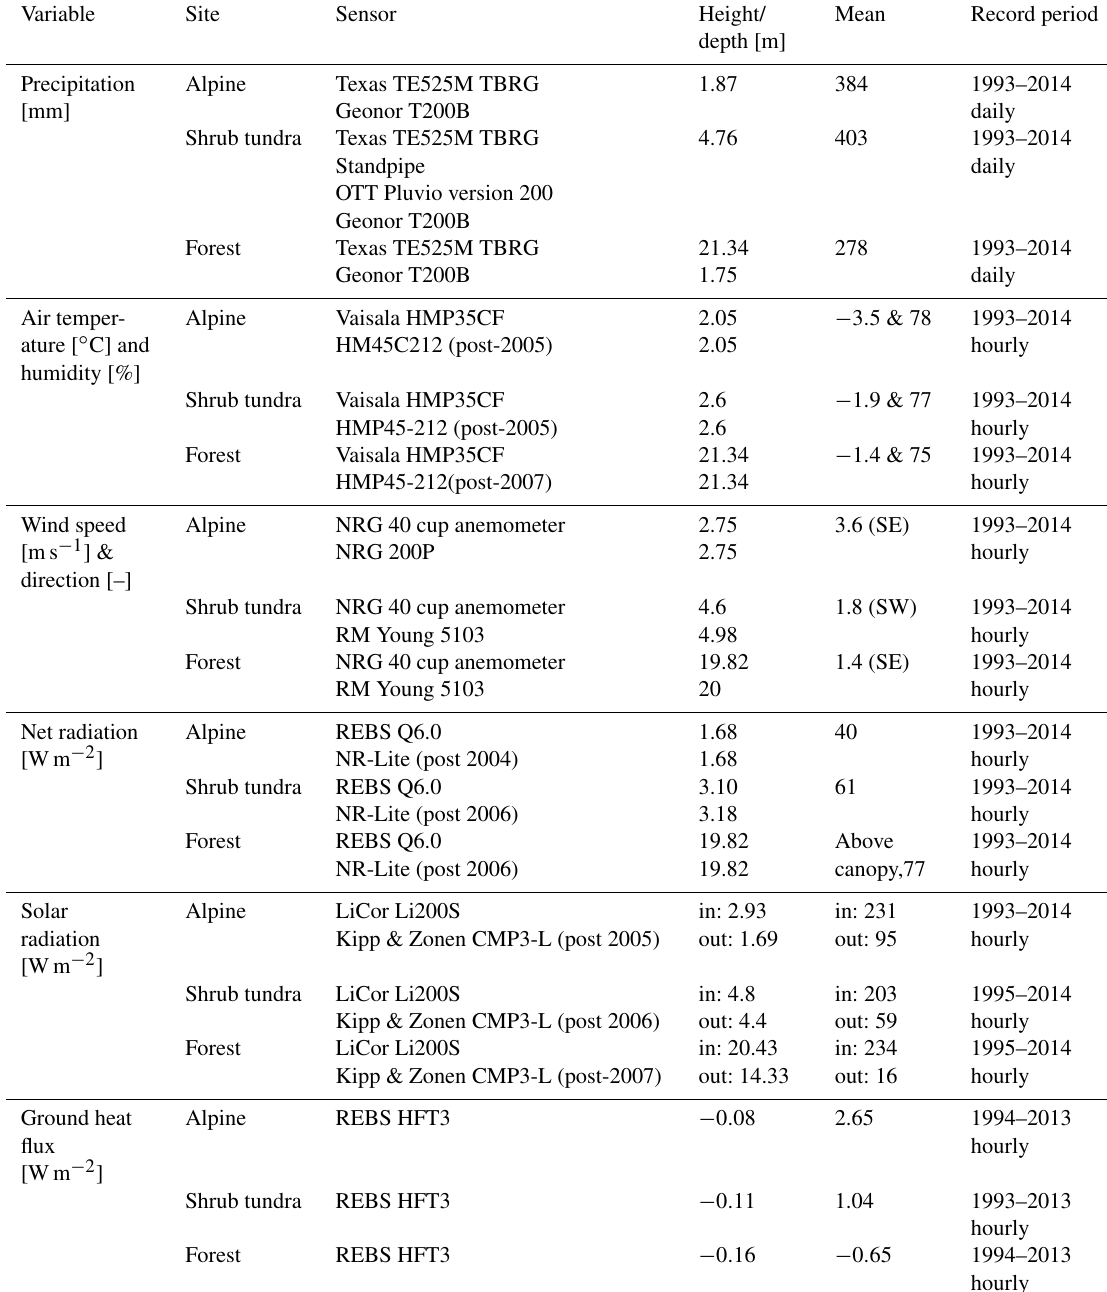
Table 2. Meteorological data measured at three sites in the basin including variables, climatological water year mean values, current sensors, and measurement